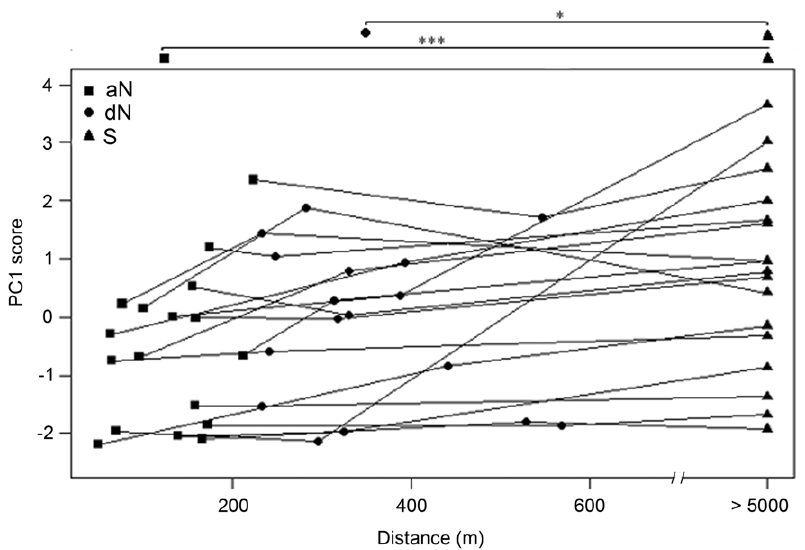
Figure 3. Playback responses. Individual PC1 scores ( n= 17) for playbacks of adjacent Neighbour songs (aN, squares), distant Neighbour songs (dN, circles) and Stranger songs (S, triangles) plotted against the distance between the subject’s territory and the territory of the individual whose song was used as a stimulus. Lines show repeated measures of the same individual between song treatments. Higher positive PC1 scores correspond to stronger responses. Responses to S songs are significantly stronger than responses to both aN and dN songs (Tukey HSD test, * p , 0.05, *** p , 0.001). Responses to aN and to dN songs are not significantly different and are not affected by the distance between territories.